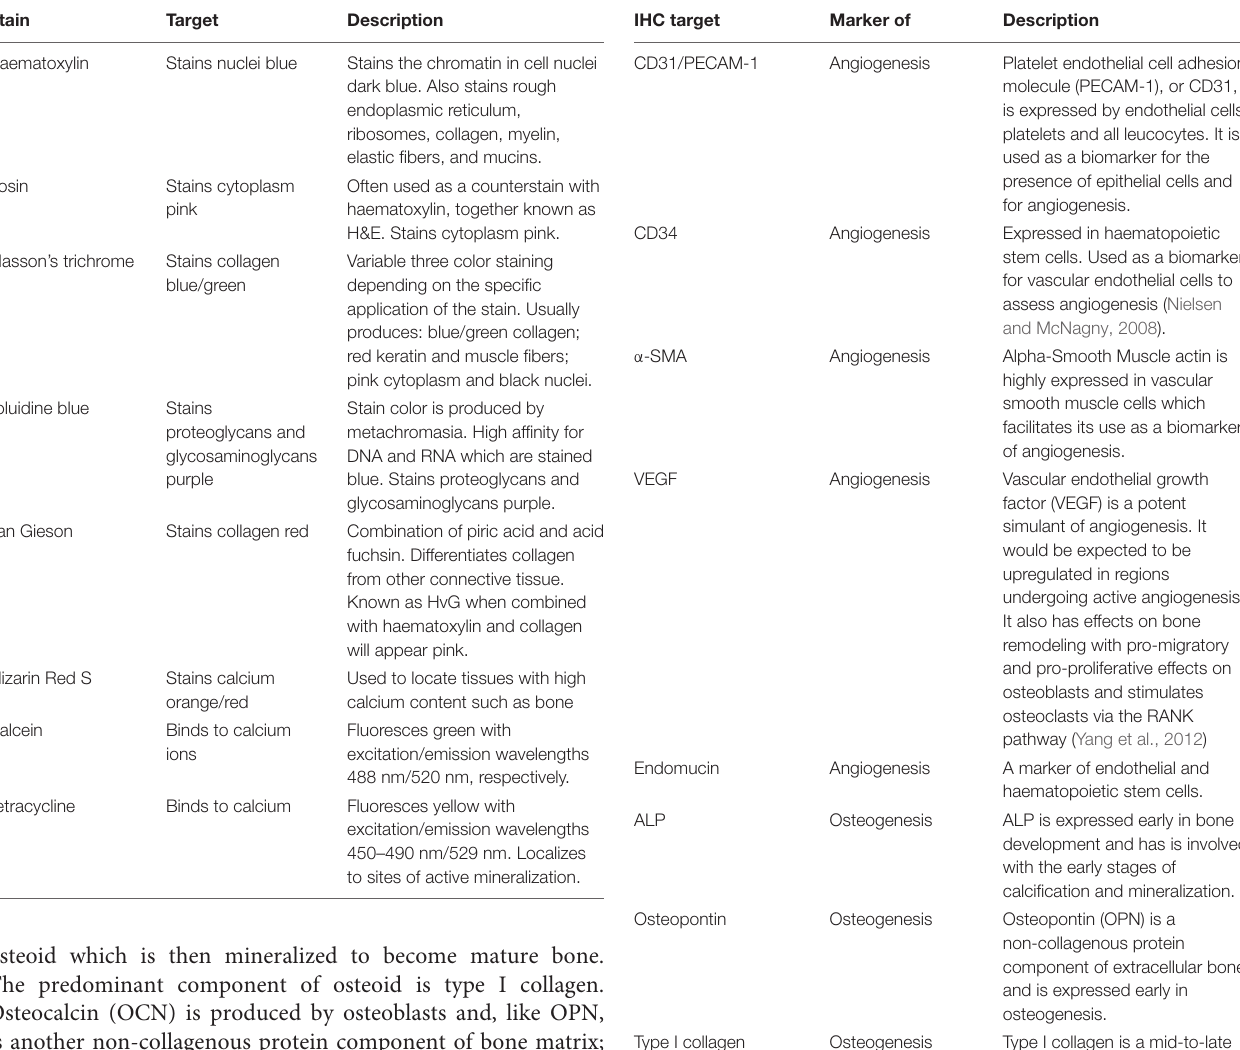
TABLE 2 | Common IHC targets used to quantify angiogenesis and